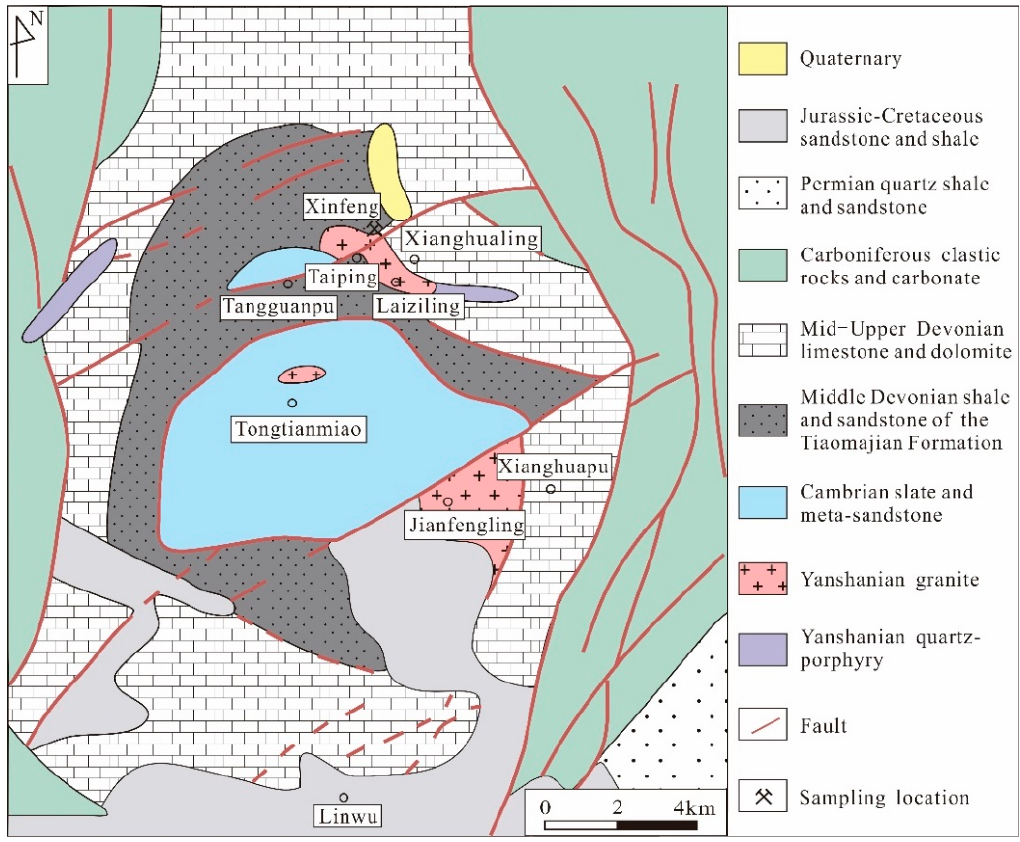
Figure 2. Geological map of the Xianghualing skarn Sn deposit (modified after [6]).